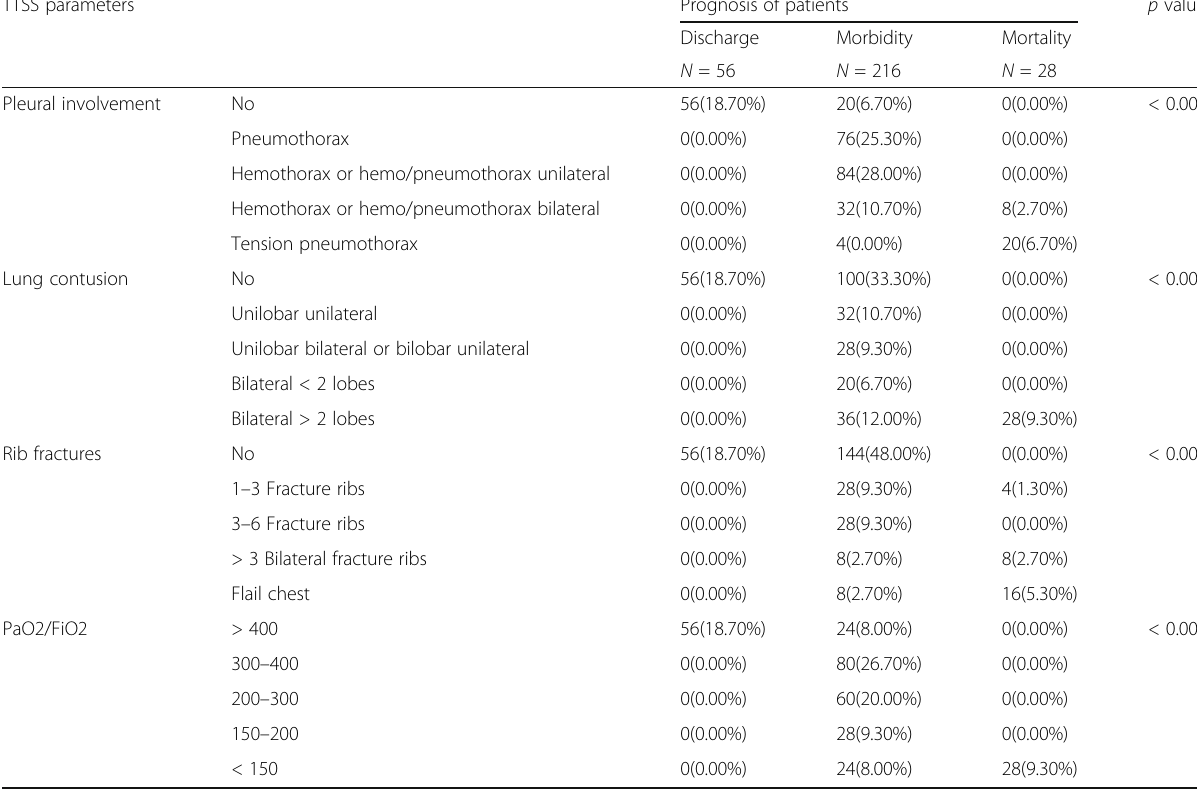
Table 3 Patients ’ outcome distributed according to thorax trauma severity score (TTSS)